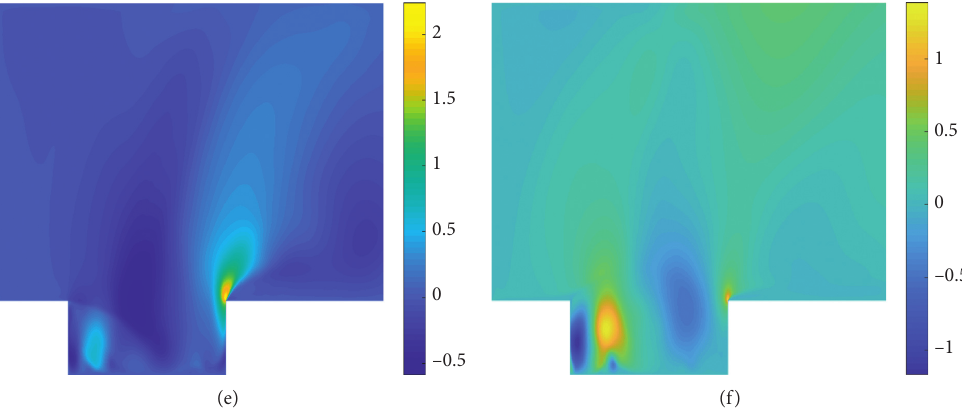
� 98.26), (b) DNS ( tU ∞ / L ∞ /